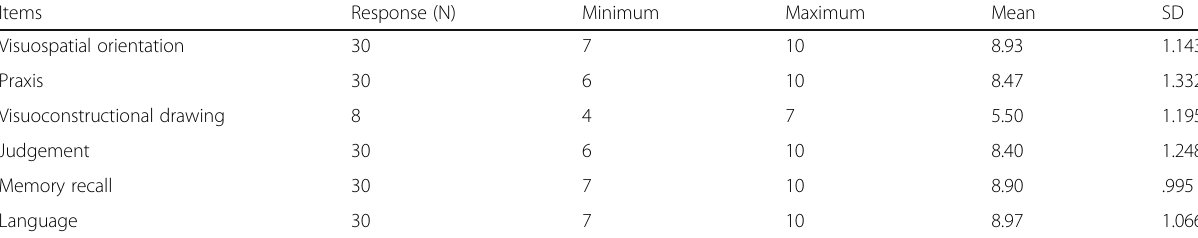
Table 2 Likert scale (understanding the items of Nepali-RUDAS)